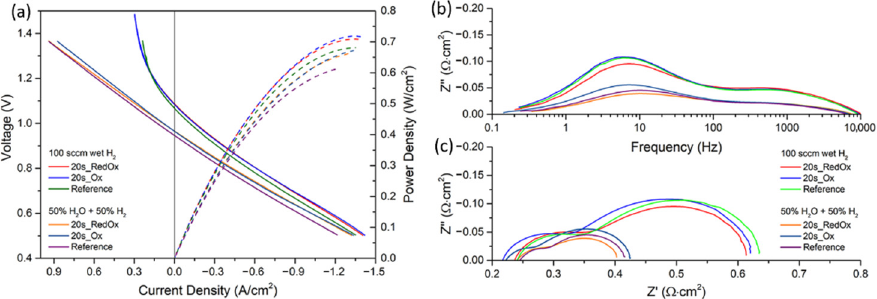
Figure 5. Plots of the examined cells measured at 750°C: ( a ) I-V curves; ( b ) Bode plot; ( c ) Nyquist